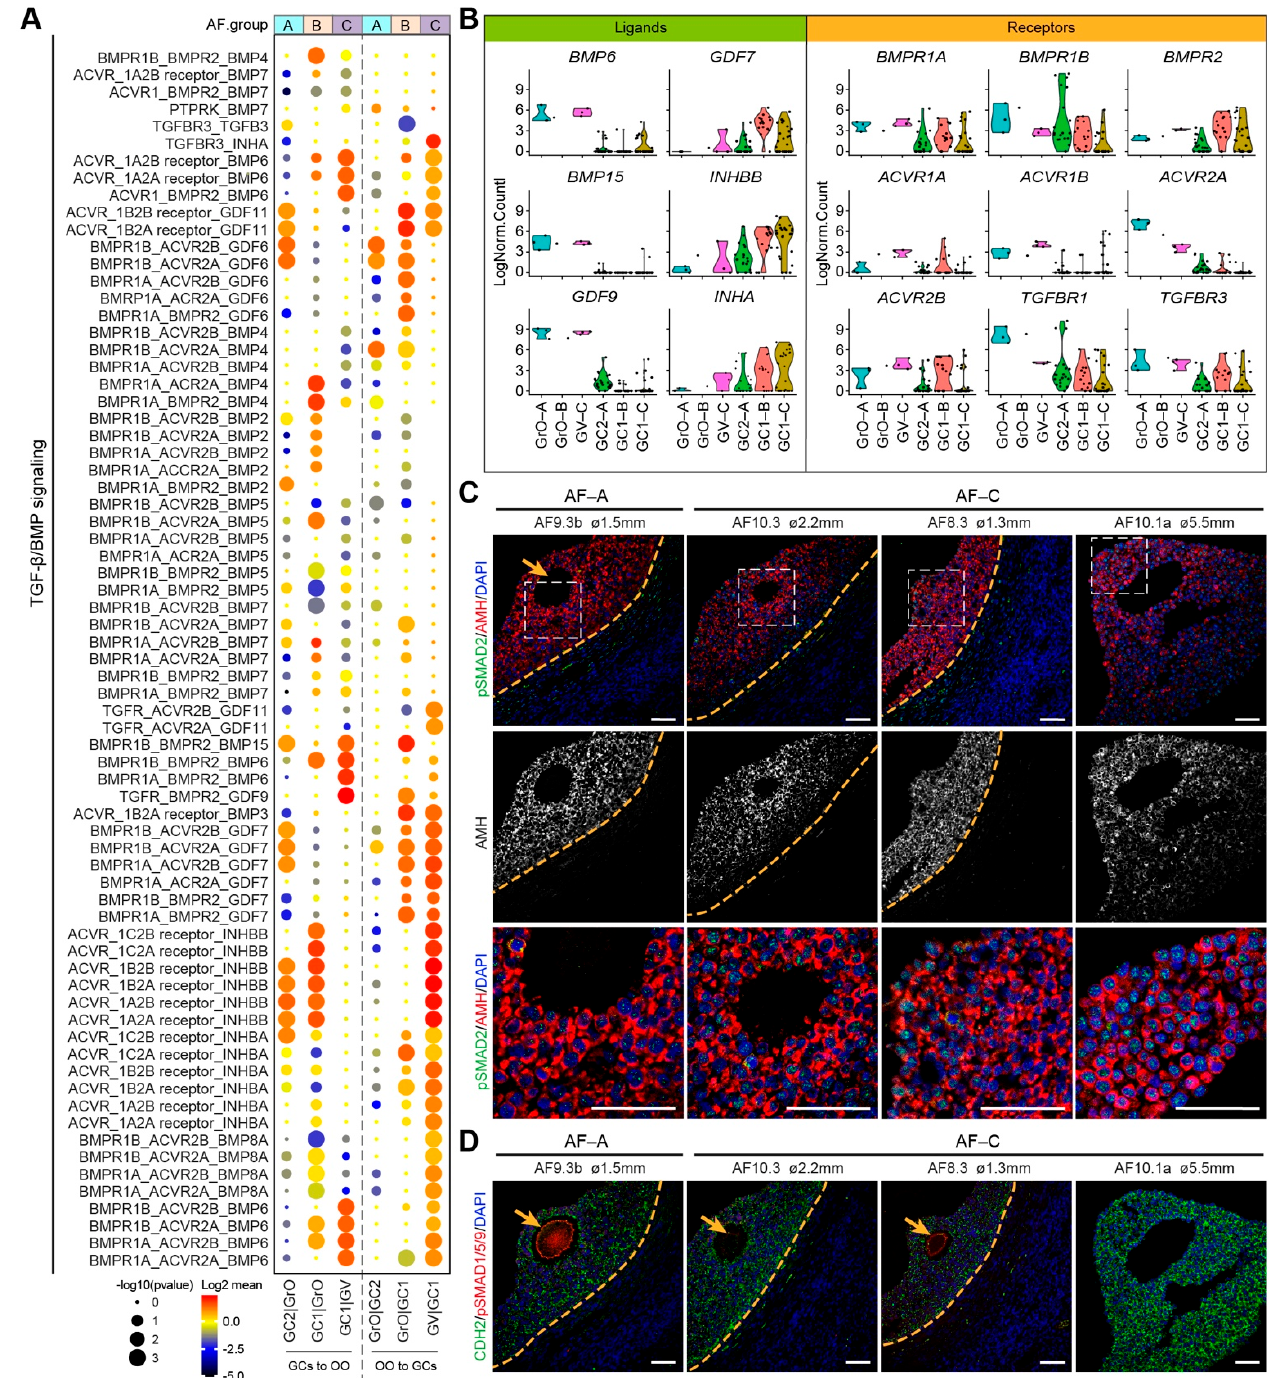
Figure 5. TGF- β /BMP signaling ligand–receptor interactions in different types of small antral follicles. ( A ) CellphoneDB analysis of TGF- β /BMP signaling interactions between oocytes and GCs in different types of antral follicles; ( B ) Violin plots of selected TGF- β /BMP signaling ligand and receptor genes in OO.groups and GC.groups; ( C ) Immunofluorescence for pSMAD2 and AMH (top panels) and single channel for AMH (middle panels) on small human antral follicles showing the follicle area close to the oocyte. White dashed boxes are showed in a high magnification in the bottom panel. Orange arrows indicate the oocyte. Orange dashed lines indicate the follicular basement membrane; ( D ) Immunofluorescence for pSMAD1/5/9 and CDH2 on small human antral follicles showing the follicle area close to the oocyte. Orange arrows indicate the oocyte. Orange dashed lines indicate the follicular basement membrane. ø, follicle diameter. Scale bars are 50 μ m.